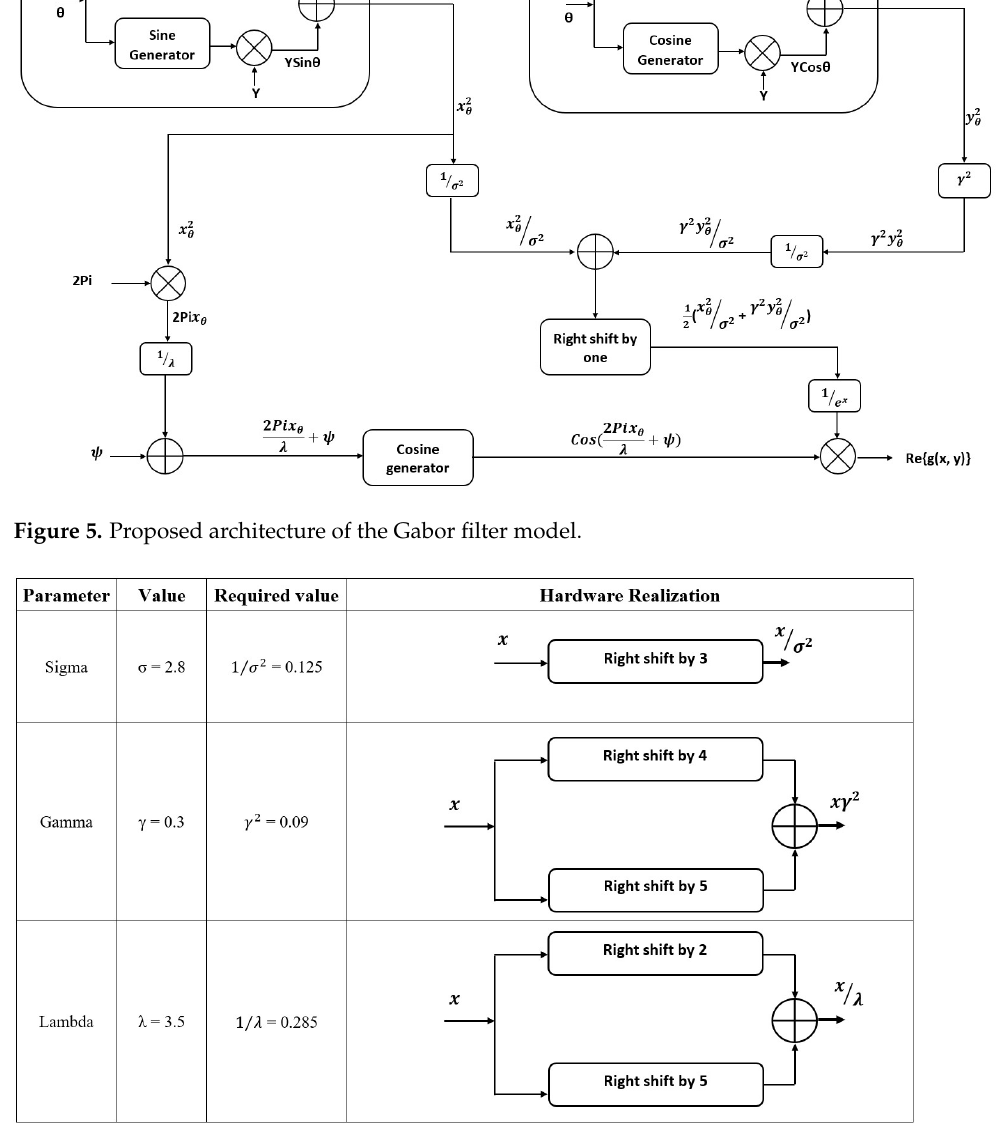
Figure 6. Hardware models for realizing the fractional values of parameters involved in the Gabor